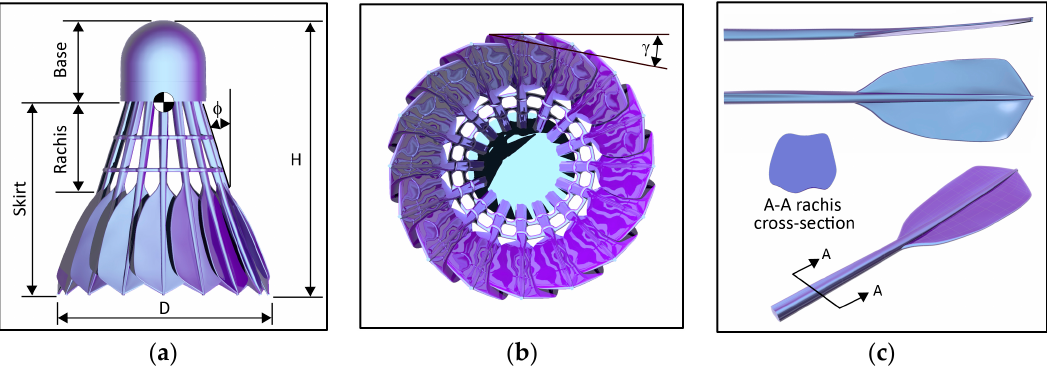
Figure 1. ( a ) Modeled baseline shuttle geometry; ( b ) aft view of shuttle showing vane angle γ ; ( c ) individual feather geometry, showing curve of feather and rachis